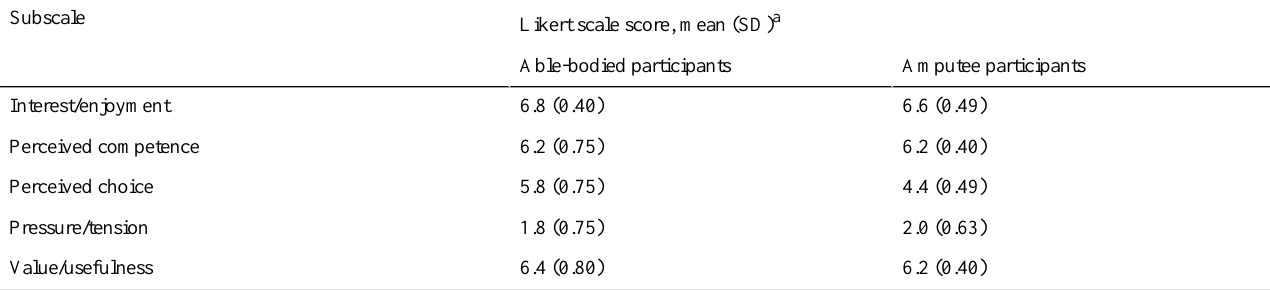
Table 2. Intrinsic Motivation Inventory questionnaire results based on five subscales.